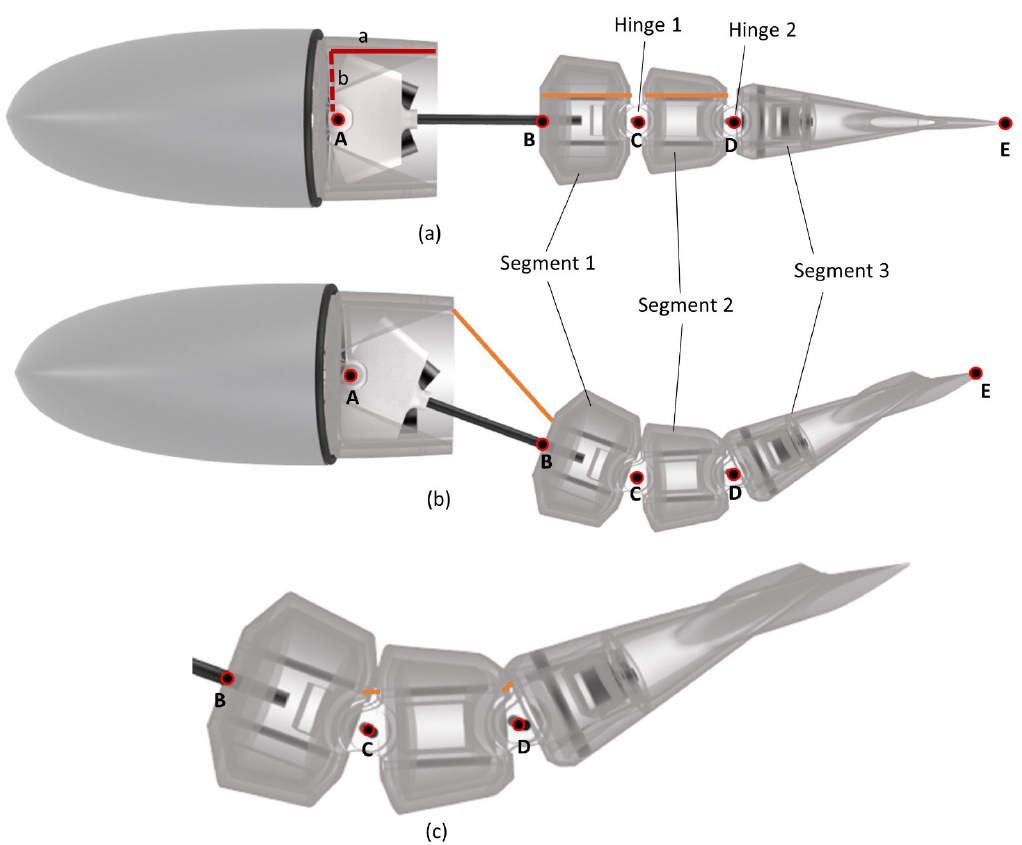
Figure 5. Rendering of the robotic fish with straight position ( a ), bended position ( b ), particular of segments during bended position ( c ). Segments and joints are clearly shown. Point A represents the rotation hinge of the whole posterior part of the robotic fish, Points C and D represent the hinges of relative rotation between segments, and Points B and E are the starting point of Segment 1 and the final point of Segment 3, respectively.